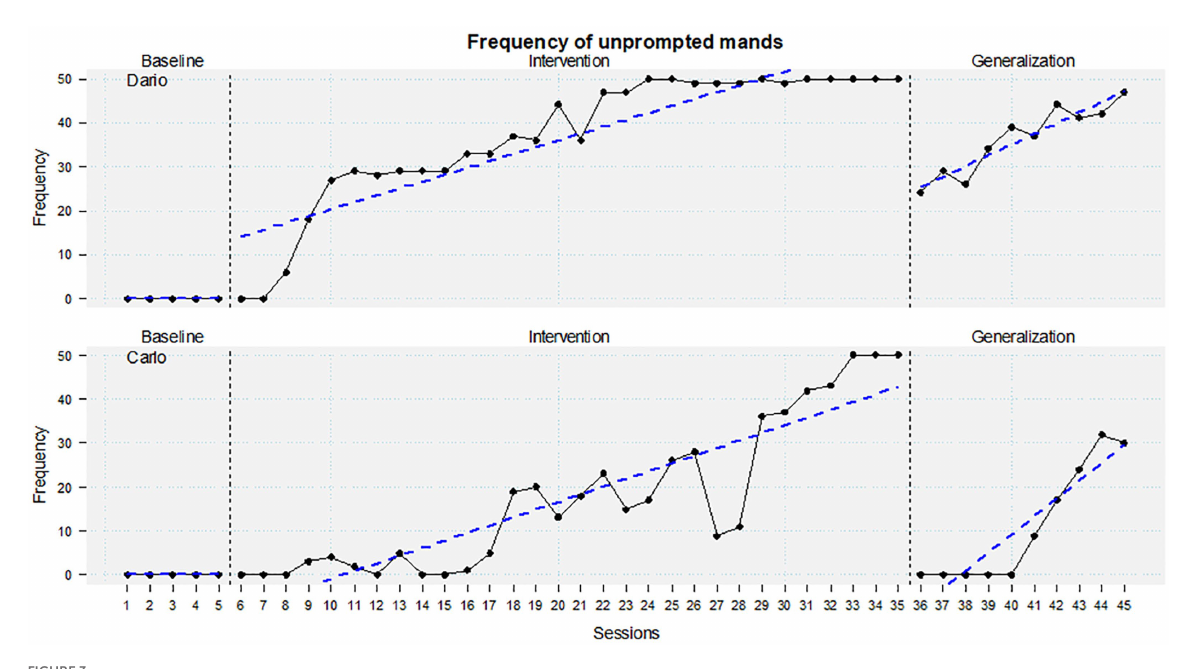
FIGURE 3 Scatterplot comparing baseline, intervention, and generalization of the unprompted mands for Carlo and